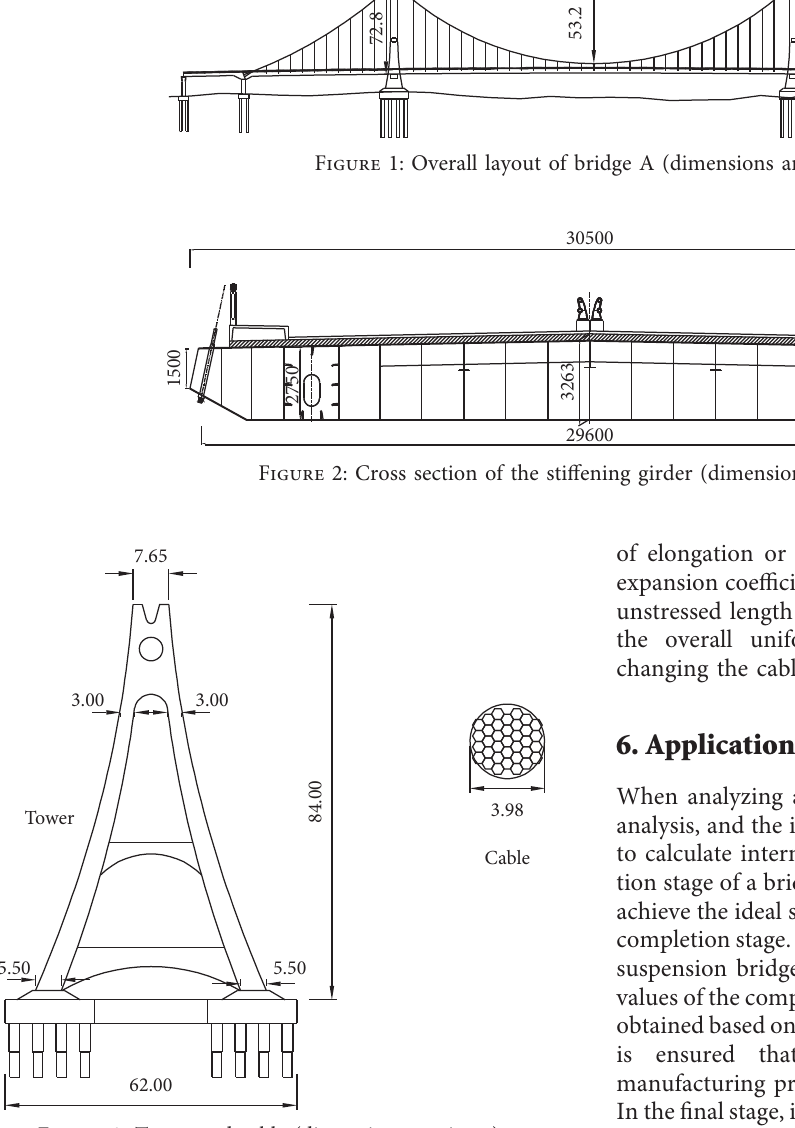
Figure 3: Tower and cable (dimensions are in m).